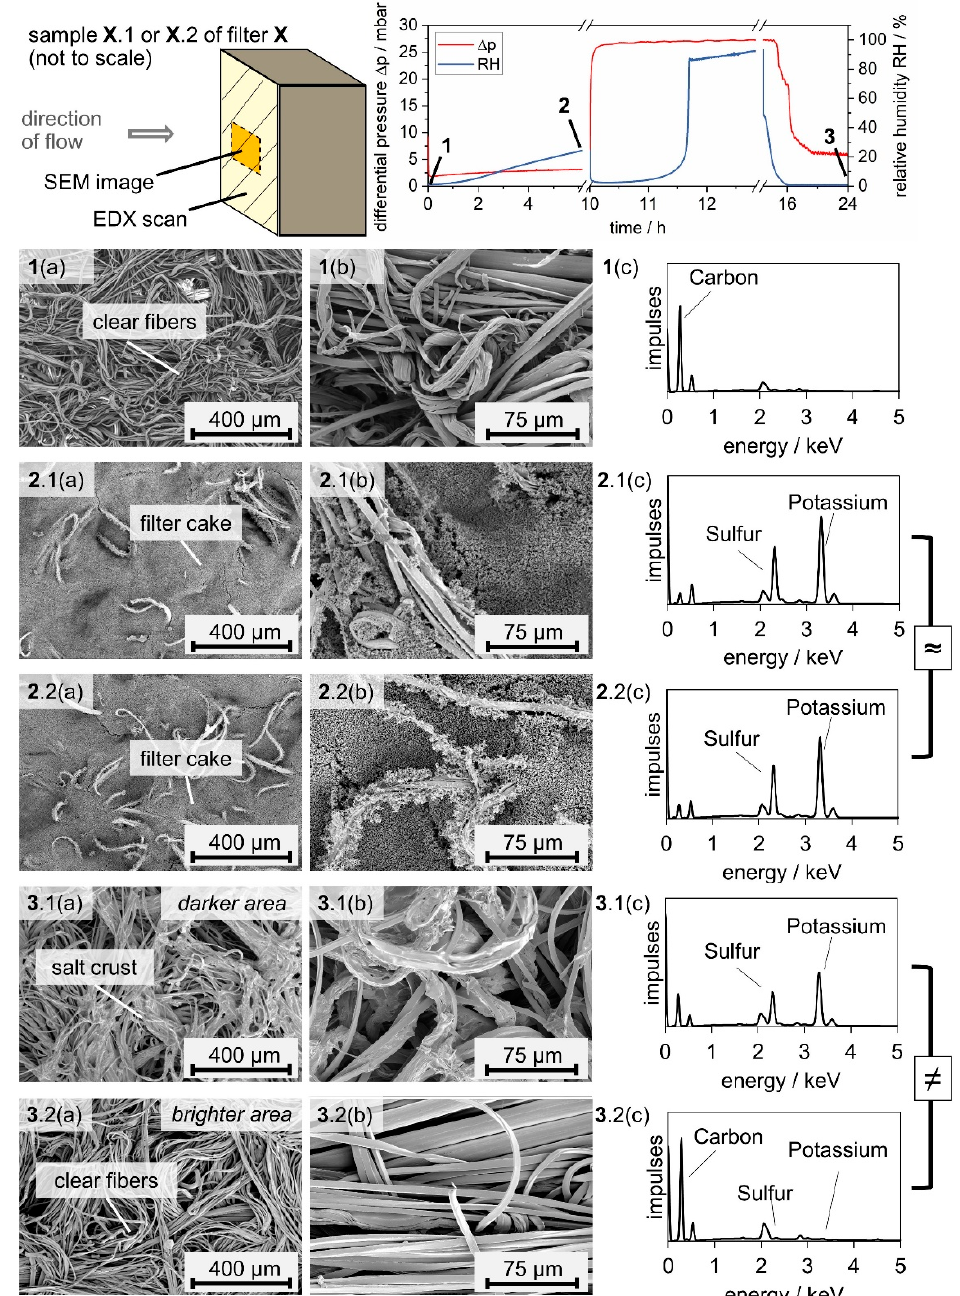
Figure 8. SEM images in small scale, magnification factor ×100 ( a ) and large scale, magnification factor ×500 ( b ) and relevant full-sample EDX area scans ( c ) of one sample before particle loading ( 1 ) and of two samples after particle loading ( 2.1 , 2.2 ) and after water exposure and drying ( 3.1 , 3.2